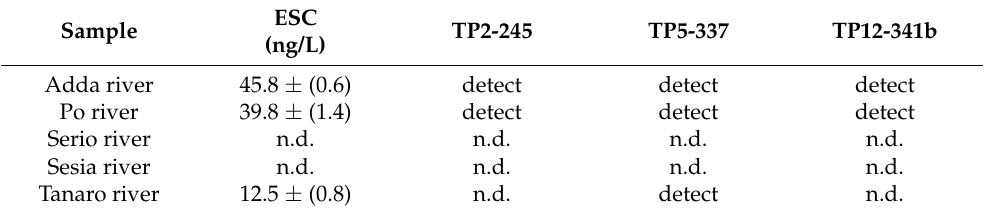
Table 3. Quantification data in the real samples (n.d. for not